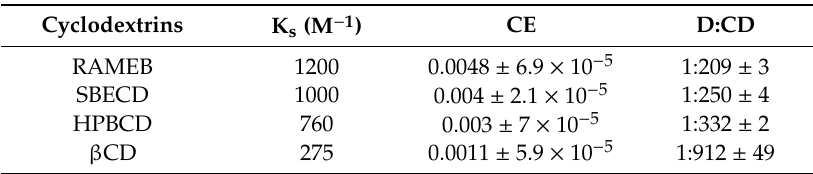
Table 2. Stability constants (K s ) complexation efficiency (CE) and the drug:cyclodextrin molar ratio (D:CD) of chrysin–cyclodextrin complexes (n = 3).